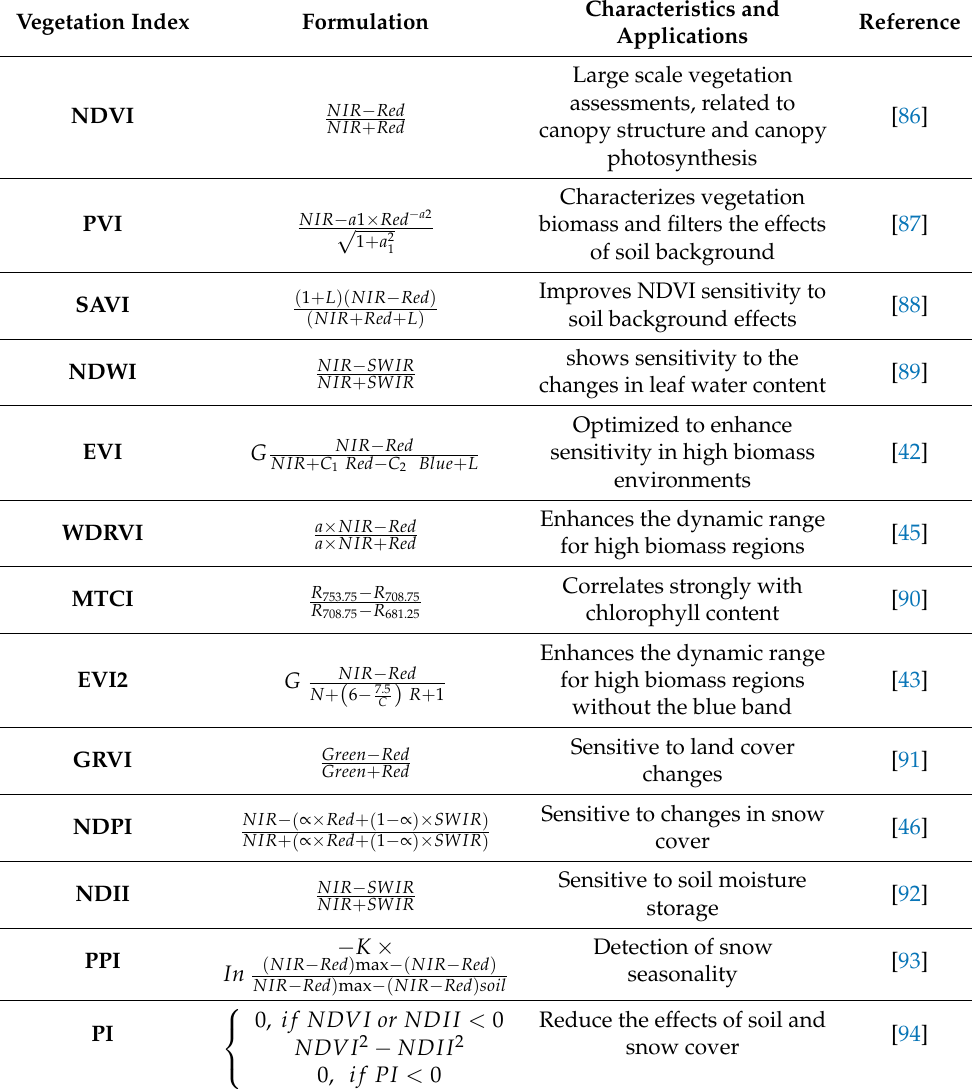
Table 2. Summary of widely used VIs in LSP and their